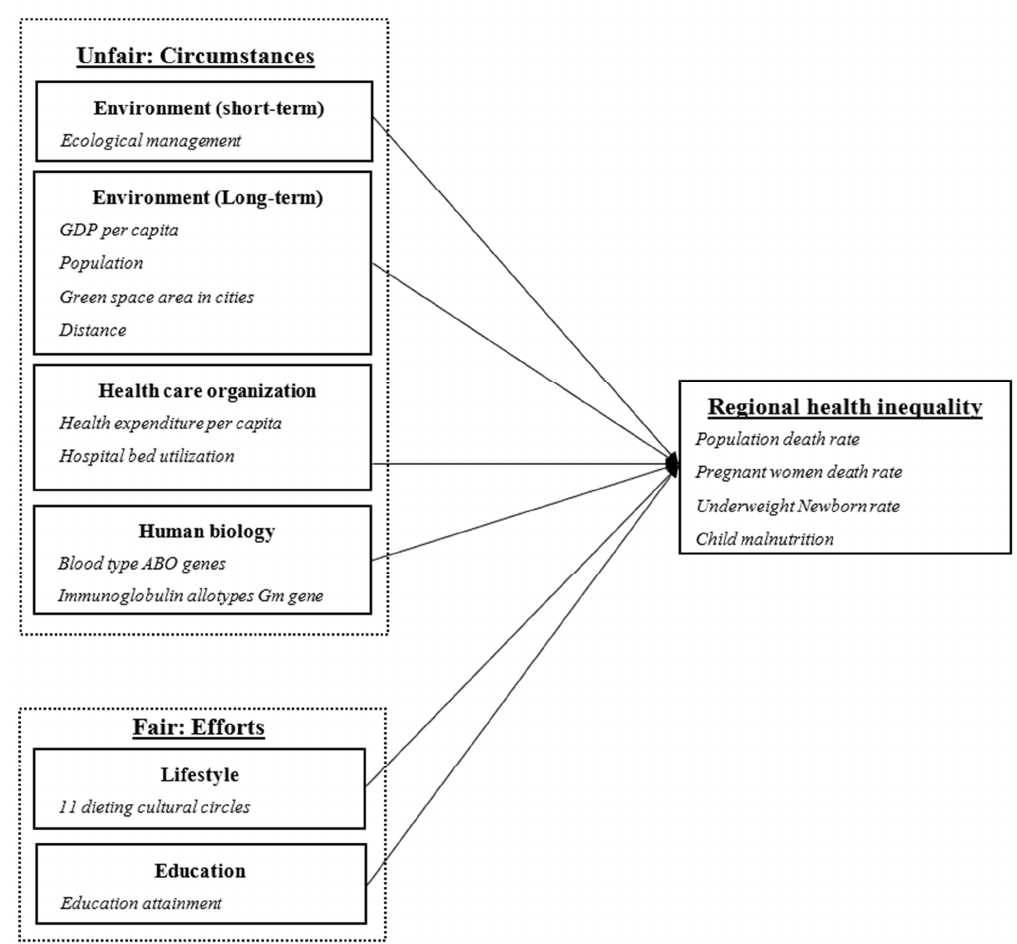
Figure 1. The conceptual framework of the impact of ecological management on regional health inequality. Source: The Health Field Concept model by Lalonde [14] and the Effort–Circumstances theory by Roemer [23].